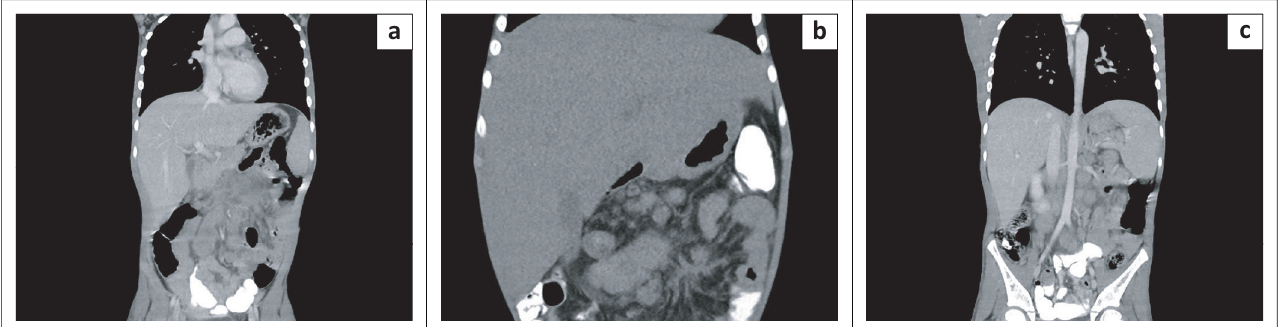
FIGURE 1: Radiology (computed tomography coronal images of the chest, abdomen and pelvis, a–c). Multiple conglomerate nodal masses are seen along the mesenteric, aorta, iliac and para-aortic nodal chains. There are also enlarged nodes in the porta hepatis. Several of the upper abdominal mesenteric nodes demonstrate low density, compatible with central necrosis. Diffuse hepatomegaly with no discrete lesion is Biochemical/ haematological parameter